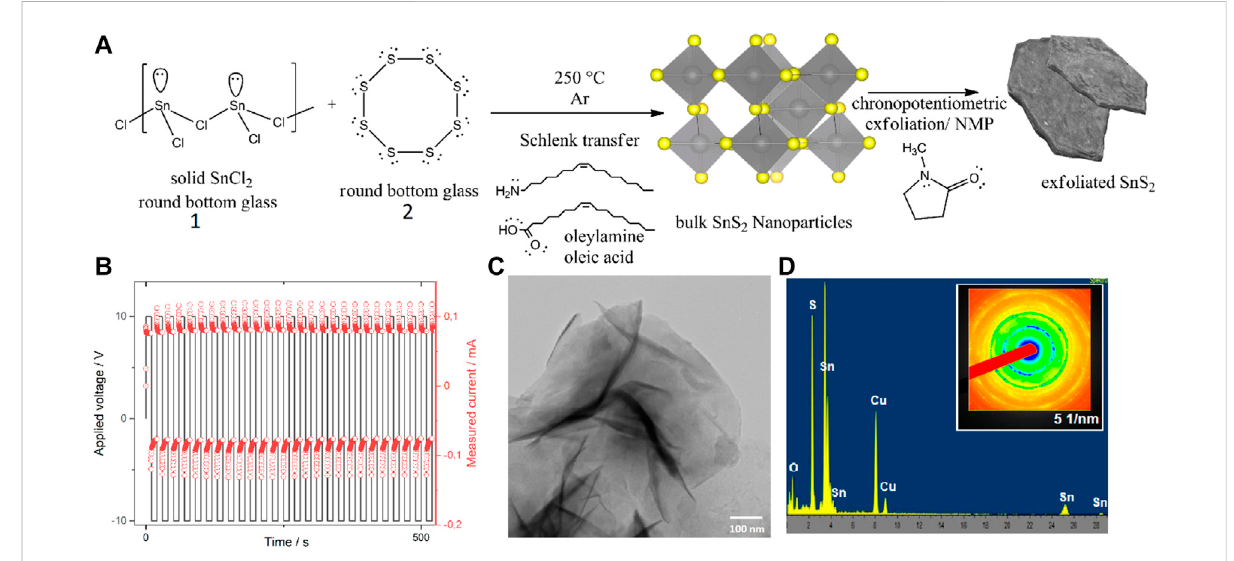
FIGURE 1 Synthesis and characterization of 2D layered SnS 2 . (A) Reaction scheme and (B) potential/current/time relation during the mixed character exfoliation (each cycle consists of single square wave). (C) TEM bright- fi eld image with dark diffraction spots and (D) SAED pattern of prepared SnS 2 with an inset image of the exfoliated SnS 2 in water (which prior the exfoliation was unable to get dispersed). For details see